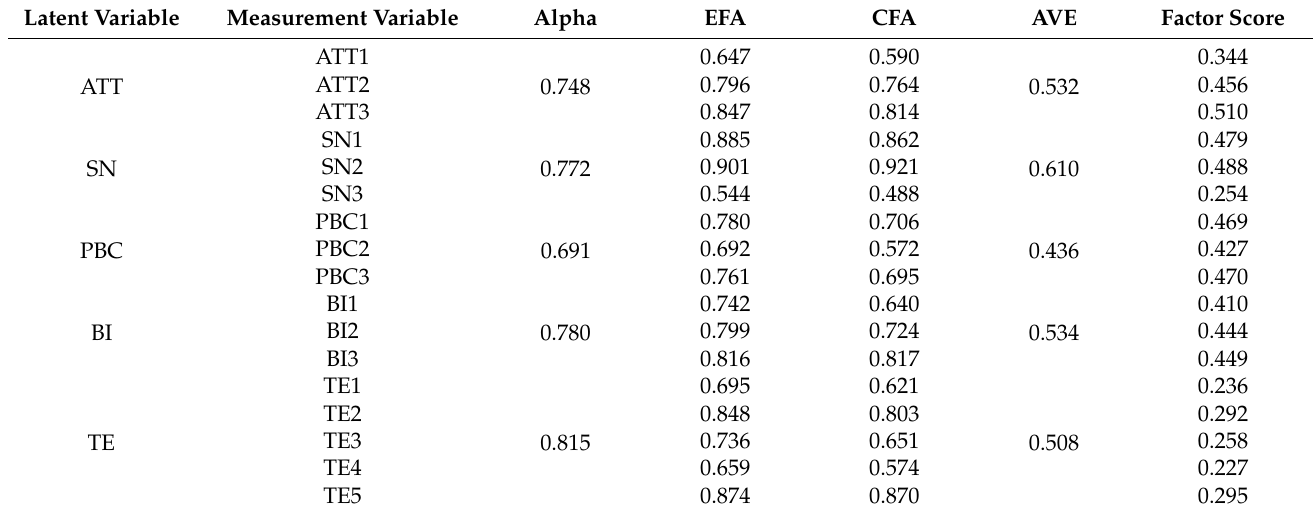
Table 4. Reliability and validity test.